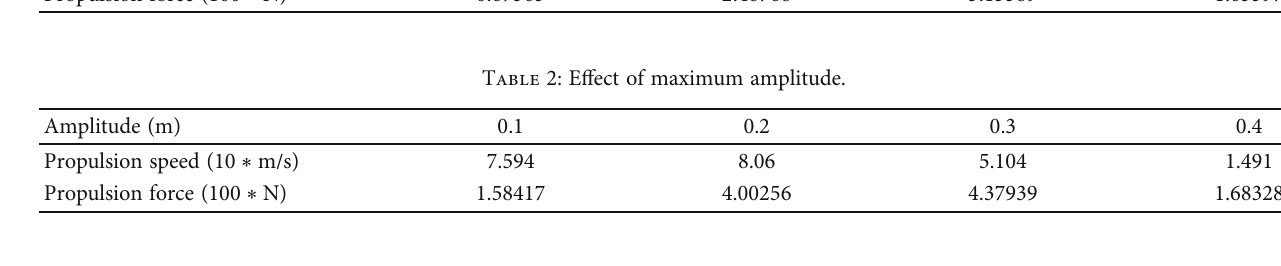
Table 3: In fl uence of phase di ff